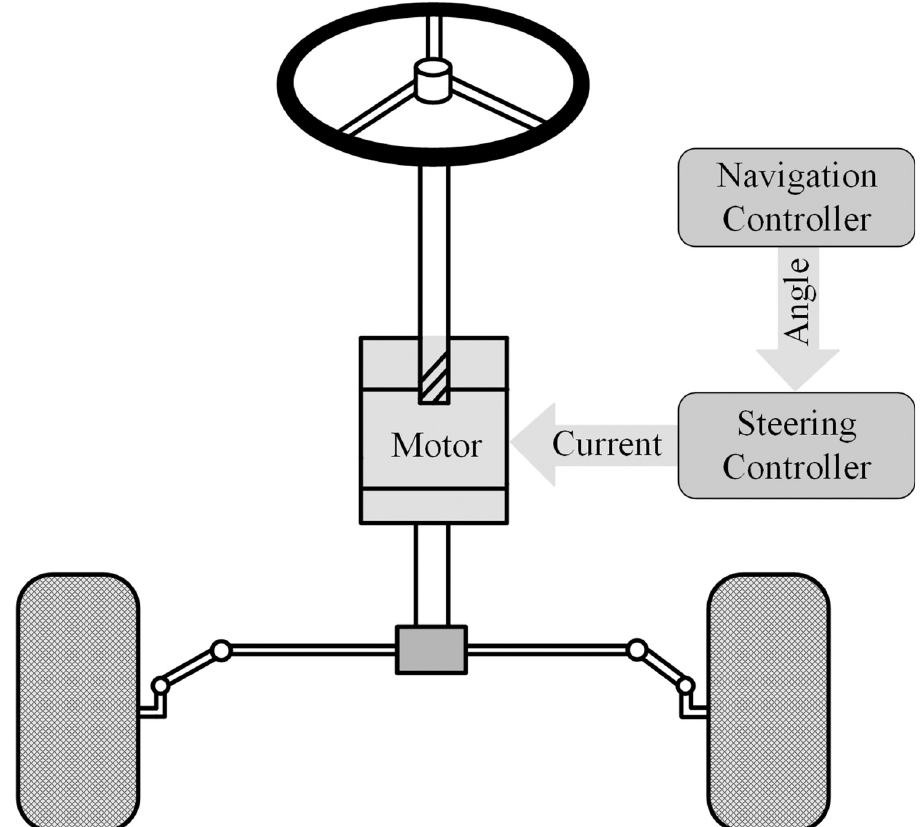
Fig 1. Trajectory tracking control system structure.